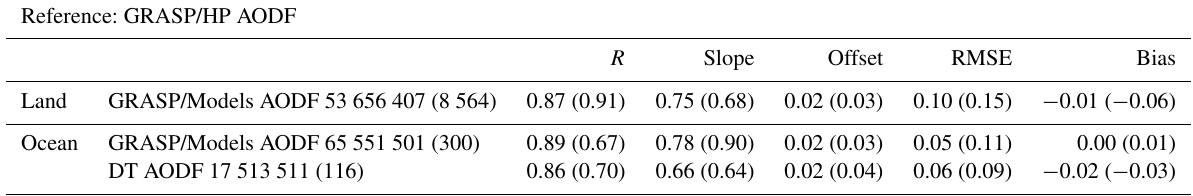
Table 20. Pixel-to-pixel statistical metrics between GRASP/HP AODF with other AODF products; the statistics for only AERONET pixels are presented in brackets.